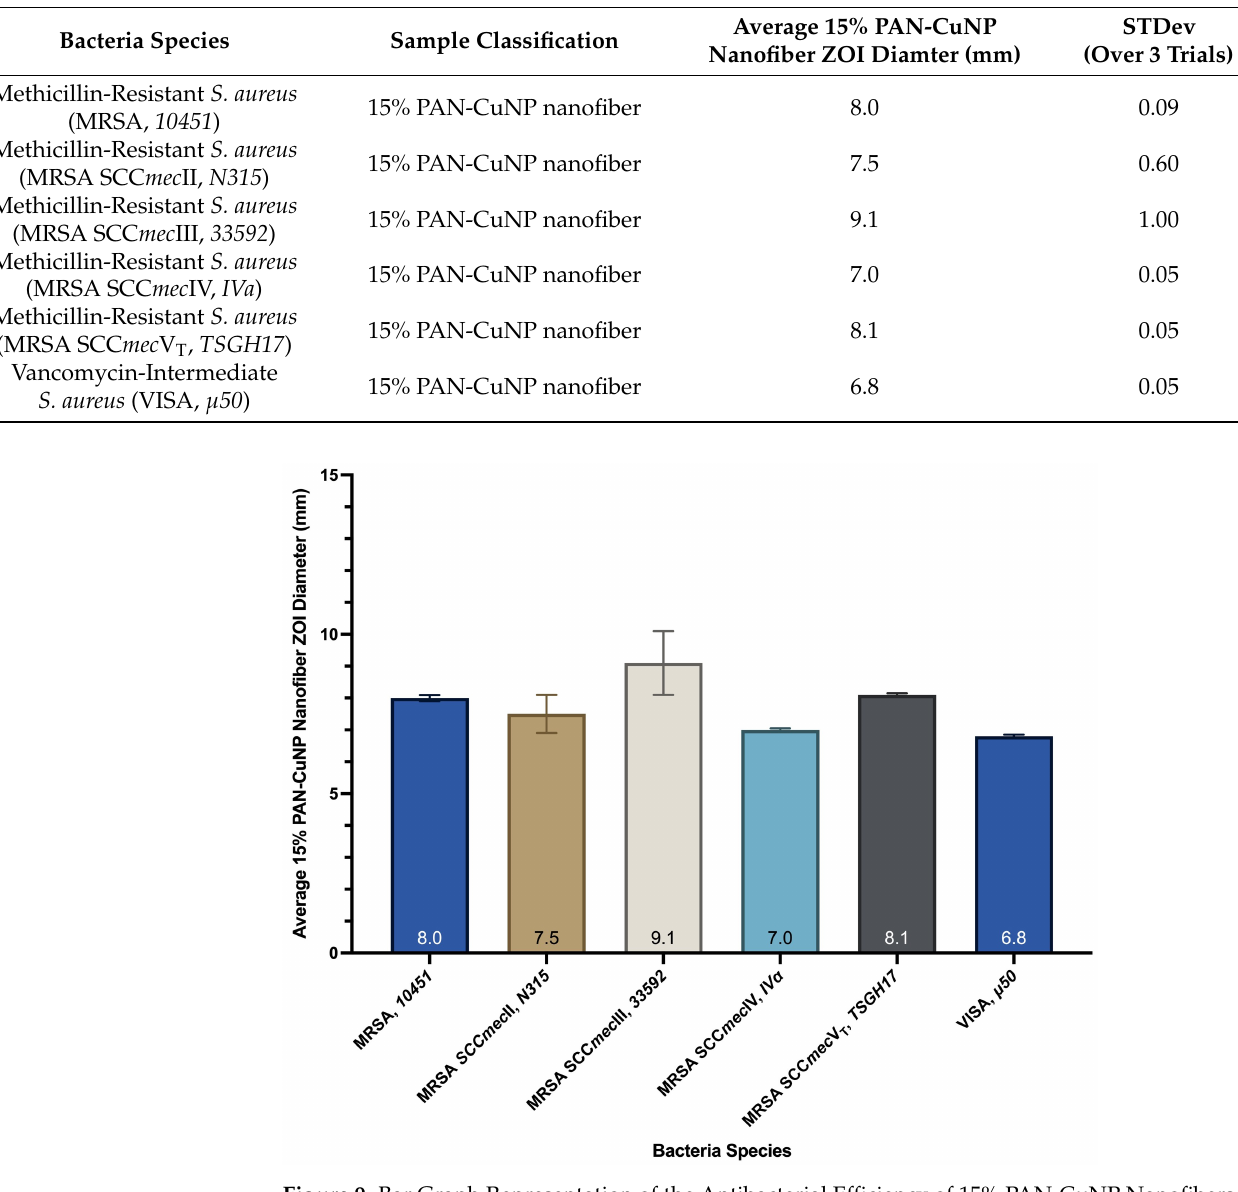
Figure 9. Bar Graph Representation of the Antibacterial Efficiency of 15% PAN-CuNP Nanofibers on Various MRSA and VISA